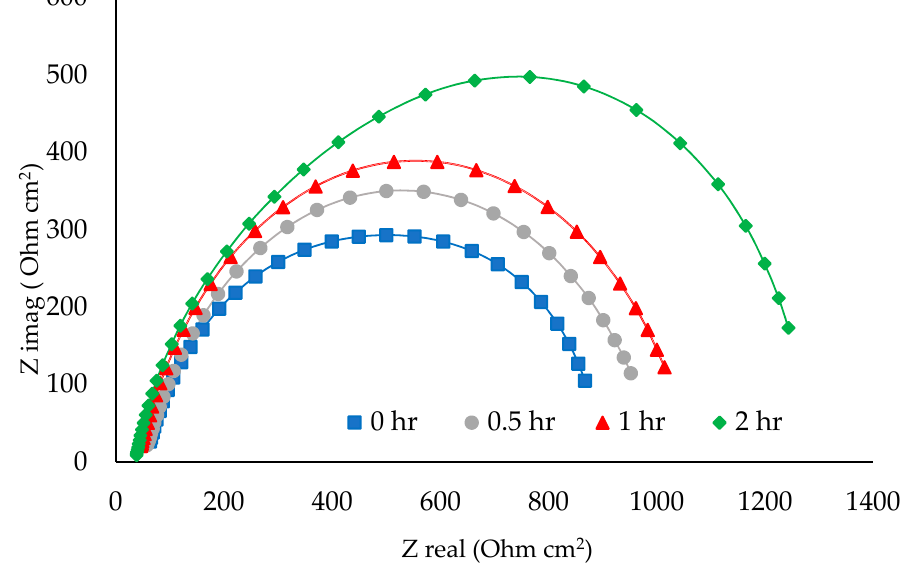
Figure 8. Nyquist plots for API X-120 steel alloy in GTL process water at di ff erent immersion times determined experimentally (point line) and fitted ones (solid